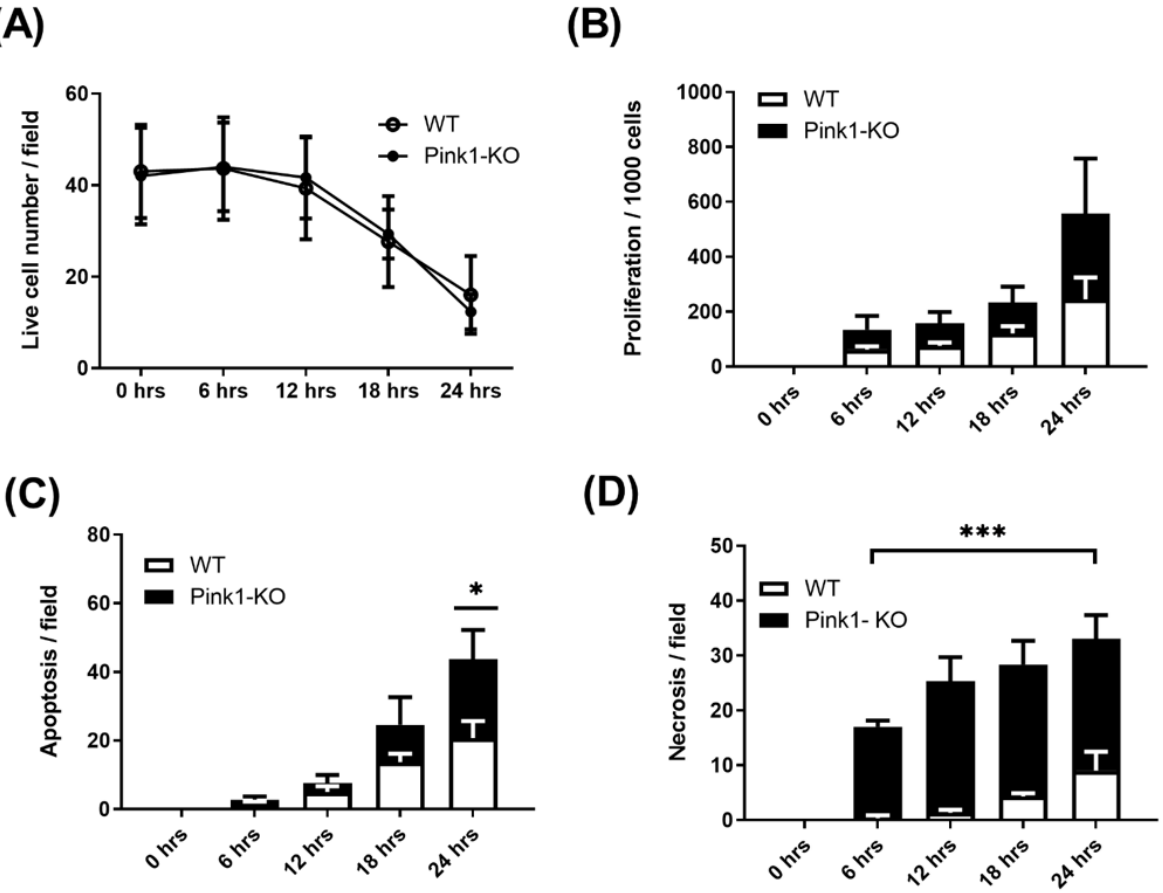
Figure 4. Live-cell comparison of wild-type (WT) and Pink1-KO VSMC: ( A ) wild-type survival, compared with Pink1-KO VSMC; ( B ) comparison of cell proliferation; ( C ) rates of apoptosis over 24 h; ( D ) rates of necrosis over 24 h. Two-way ANOVA with Bonferroni’s post hoc test ( n = 3). * p ≤ 0.05, *** p ≤